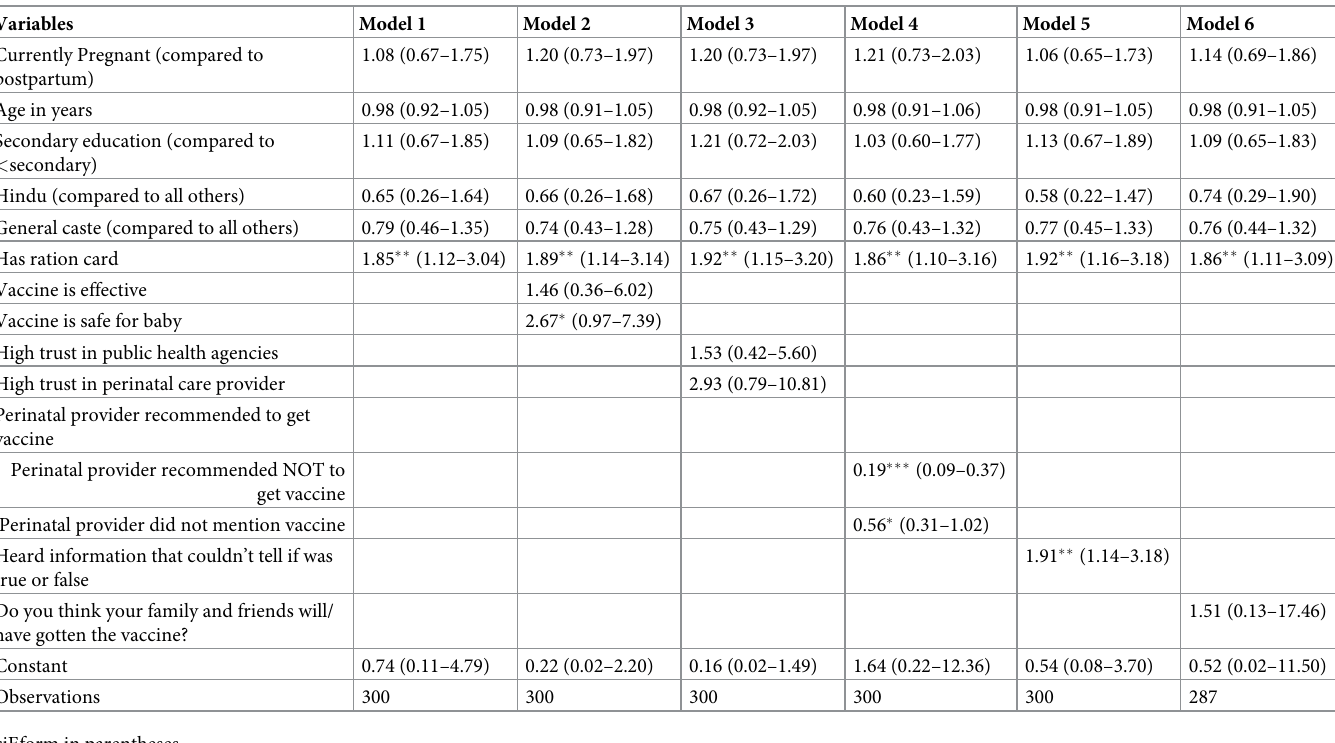
Table 3. Factors associated with being vaccinated among pregnant and postpartum